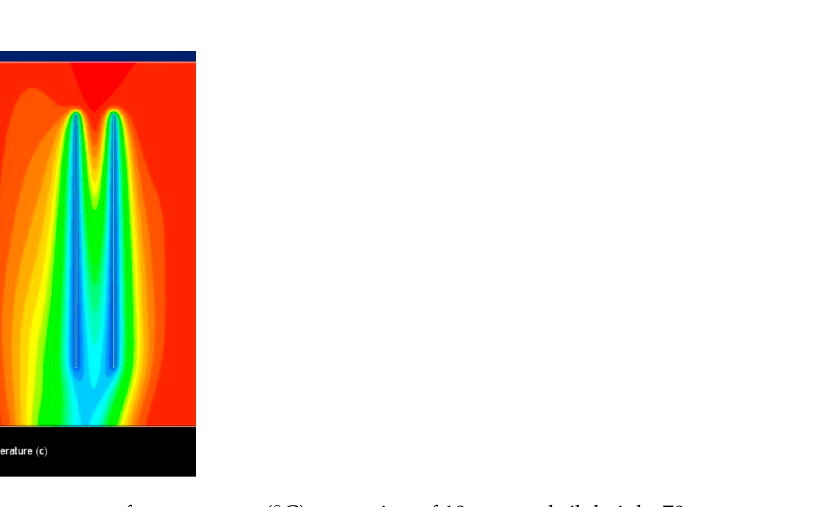
Figure 17. The contours of temperature (°C) at spacing of 10 mm and rib height 70 mm.